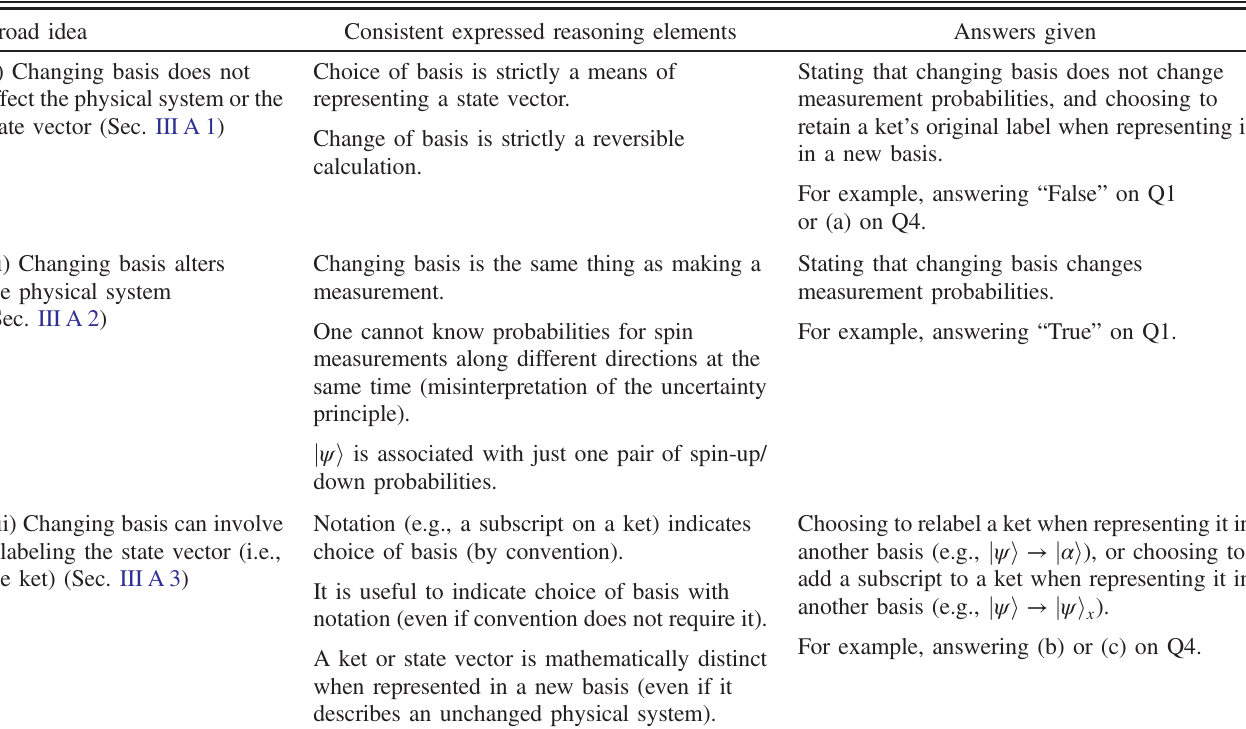
TABLE IV. Students expressed a range of reasoning elements on different questions probing their understanding of change of basis and its affect on both the physical system and the quantum state vector (ket) describing that system. Each reasoning element is consistent with one of three broad ideas, which represent possible interpretations of the effect of change of basis on a quantum state. Different questions (from Table I) invoked different reasoning elements. The table also gives examples of answers that were consistent with the broad idea. Broad